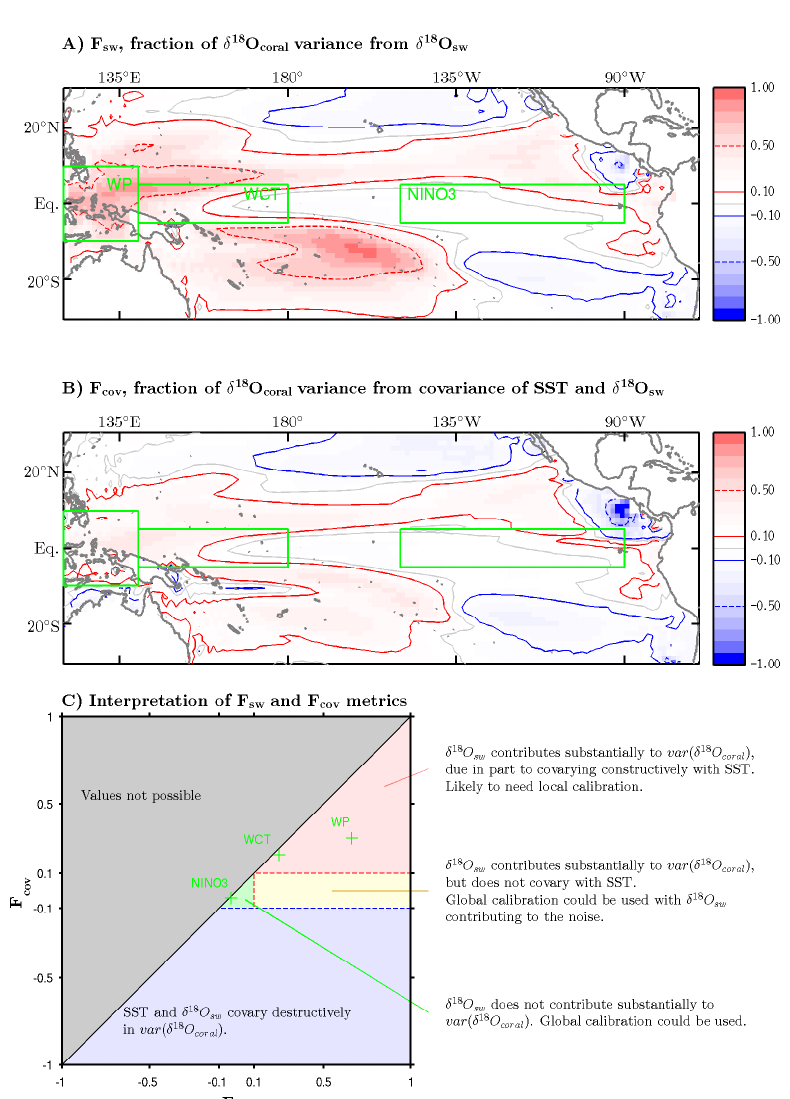
Fig. 2. The spatial distributions over the tropical Pacific domain of (A) the F sw metric, which shows the fraction of model inter-annual δ 18 O coral variance arising from δ 18 O sw variability. (B) The F cov metric, which shows the fraction of model inter-annual δ 18 O coral variance arising from the component of δ 18 O sw variability that co-varies with that in SST. The three regional boxes discussed in the text are highlighted in green, WP = warm pool, WCT = western cold tongue. Panel (C) gives a schematic guide to the interpretation of the F sw and F cov metrics. Regions of F sw and F cov space that are relevant to the discussion in the text are identified by color shading and briefly described in annotation labels. The green markers show where the metric values associated with the averages over the three boxes highlighted on panels (A) and (B) plot within such a framework.